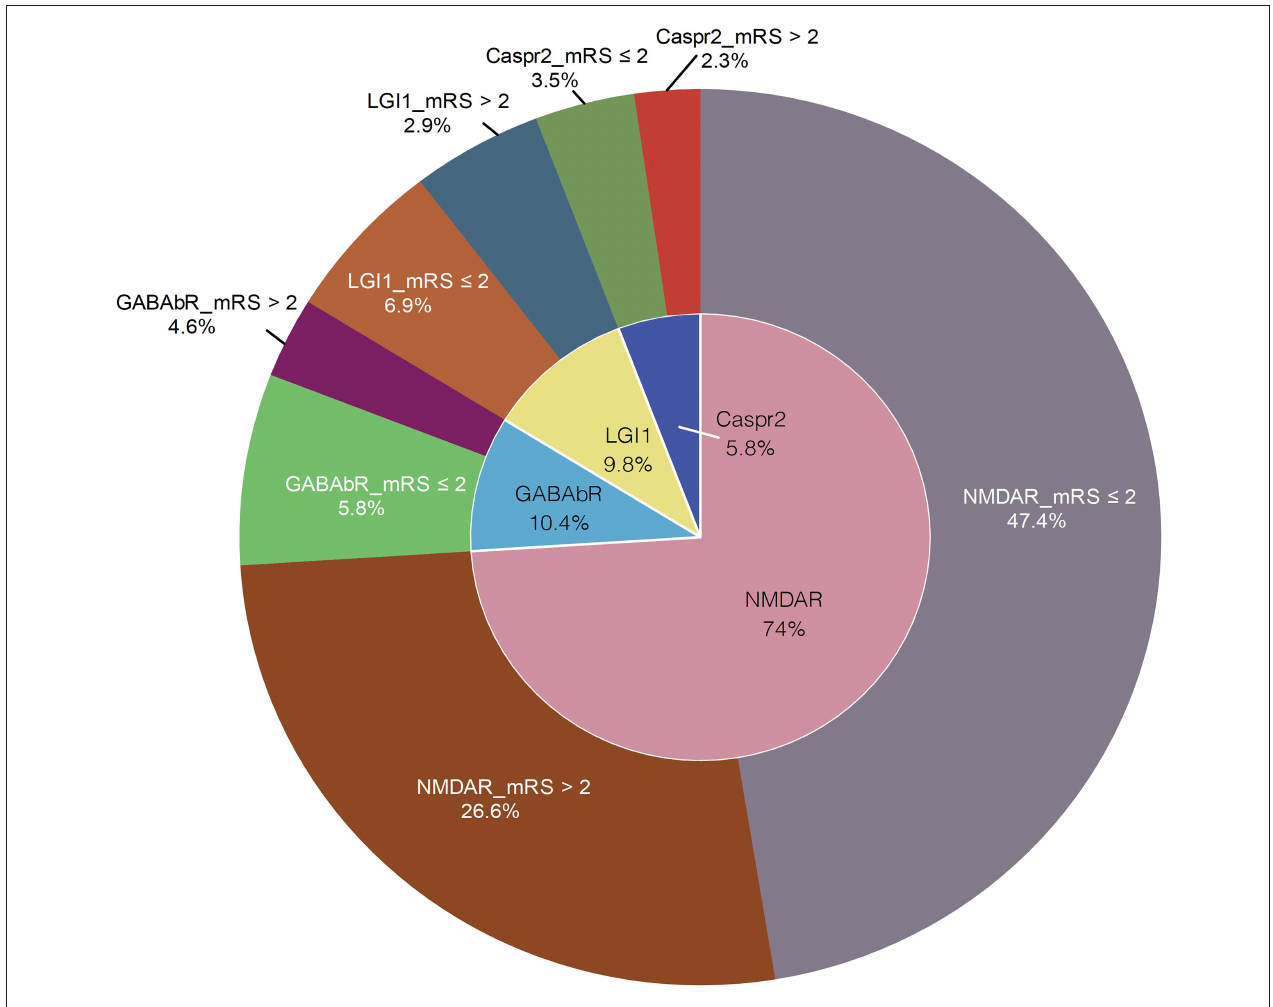
FIGURE 2 | Percentage of prognosis of subtype of